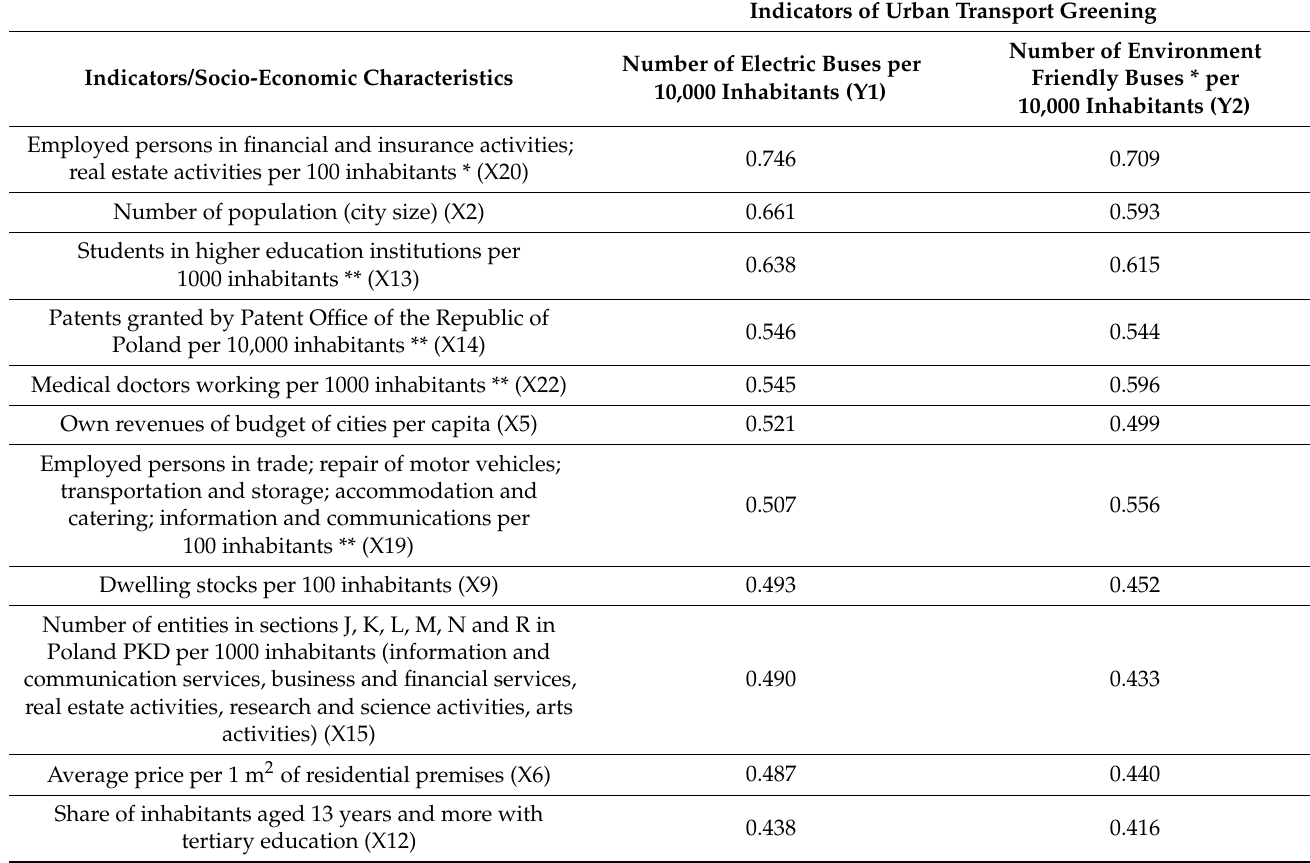
Table 10. Correlation matrix (Pearson’s correlation coefficients